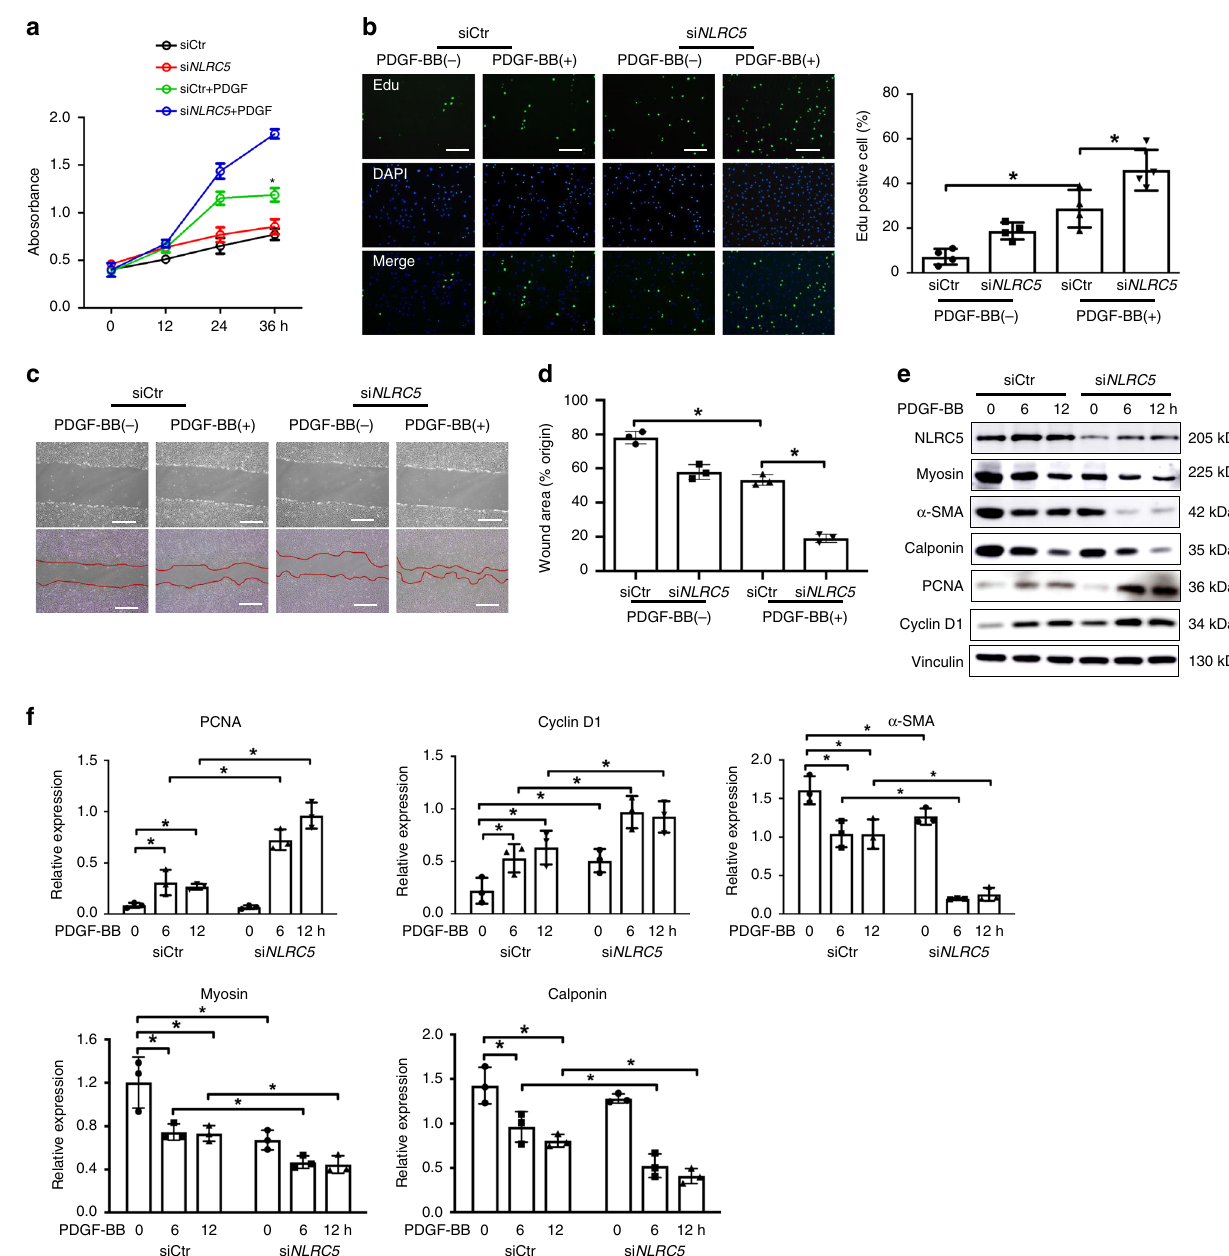
Fig. 3 NLRC5 de fi ciency aggravates VSMC proliferation, migration, and dedifferentiation. a Human aortic smooth muscle cells (HASMCs) are transfected with scramble small interfering RNA (siCtr) or NLRC5 small interfering RNA (si NLRC5 ) for 48 h. HASMC proliferation is measured by MTS assay in the presence or absence of PDGF-BB (10 ng/ml) at the indicated time points. * P < 0.05 vs si NLRC5 + PDGF at 36 h after PDGF-BB stimulation. b Edu incorporation (green) is evaluated by fl uorescence microscopy. Hoechst 33342 is used as a nuclear stain of HASMCs. Scale bar: 100 μ m. c , d After transfection with siCtr or si NLRC5 for 48 h, cell migration is assessed by scratch assay in HASMCs with or without PDGF-BB (10 ng/ml) stimulation for 12 h c . Scale bar: 100 μ m. Wound area is analyzed by ImagePro Plus software d . e , f Representative western blotting of NLRC5, PCNA, Cyclin D1, α -SMA, Calponin, Myosin, and Vinculin in HASMCs transfected with siCtr or si NLRC5 in the presence of PDGF-BB for 0, 6 and 12 h (10 ng/ml). Two-tailed Student ’ s t -test is used to compare two groups d , and analysis of variance (ANOVA) followed by Bonferroni post hoc analysis is used to compare three or more groups a , f . Data are presented as mean ± SD from three independent experiments. * P < 0.05. Original magni fi cation, ×100 ( b and c ). Source data are provided as a Source Data fi PPRE in the regulatory regions of target genes and activate gene transcriptional network, we examined the expression of well- transcription, we performed IP to determine whether the known PPAR γ target genes related to proliferation and migration, presence of NLRC5 regulated PPAR γ /RXR α complex formation. including CD36 , AP2 , and CITED2 34 – 36 . In response to siRNA- However, absence of NLRC5 did not alter the PPAR γ – RXR α mediated NLRC5 knockdown, the mRNA expressions of CD36 , interaction in HASMCs (Fig. 4j). To dissect whether AP2 , and CITED2 were signi fi cantly decreased (Fig. 4i). Given NLRC5 serves as a PPAR γ ligand without interfering with the that PPAR γ /retinoid X receptors α (RXR α ) heterodimers bind to